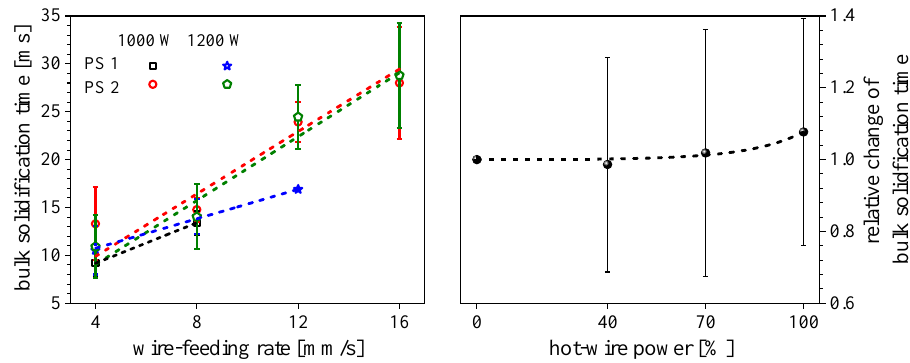
Figure 20. Bulk solidification time as function of the wire-feeding rate, averaged over all hot-wire powers ( left ), and relative change of the bulk solidification time as function of the hot-wire power, averaged over all pulse shapes, pulse energies and wire-feeding rates ( right ).